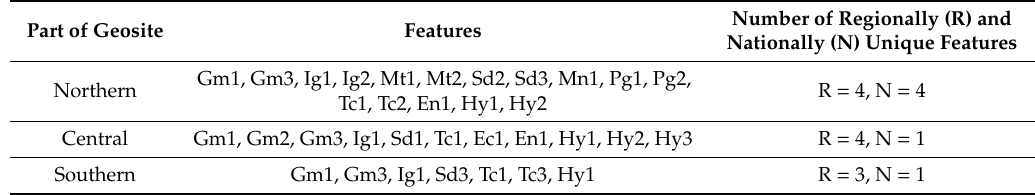
Figure 6. Schematic distribution of geological features along the Granite Gorge; abbreviations of geological heritage types: Gm, geomorphological; Ig, igneous; Mt, metamorphic; Sd, sedimentary; Mn, mineralogical; Pg, paleogeographical; Tc, tectonic; Ec, economic; En, engineering; Hy, hydrological and hydrogeological (numbers refer to particular features and are explained in the text). Table 2. Disproportion of the Granite Gorge geosite determined by the different uniqueness of the geological heritage features.